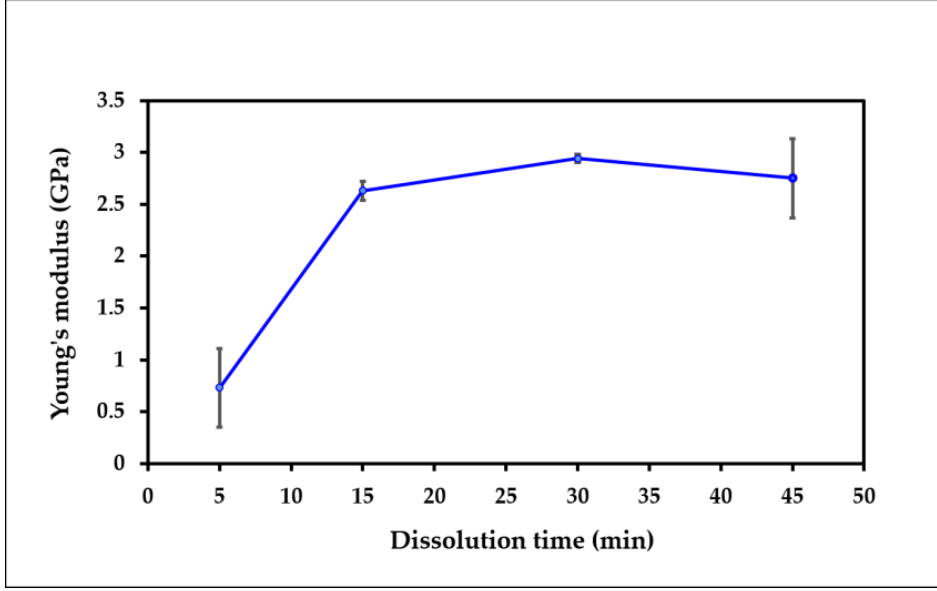
Figure 2. Modulus of elasticity of the ACC films at various dissolution times (5 – 45 min).